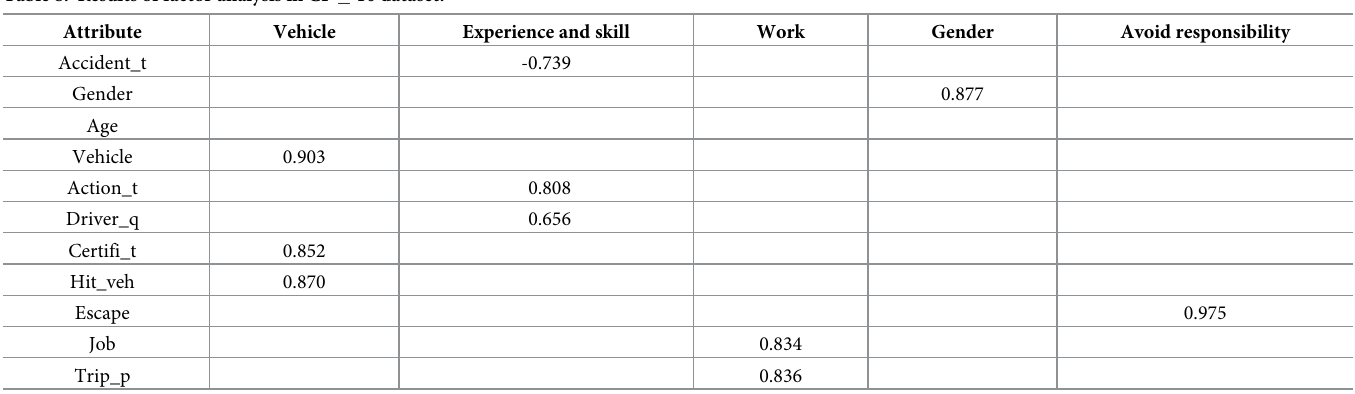
Table 8. Results of factor analysis in CF � 10 dataset.